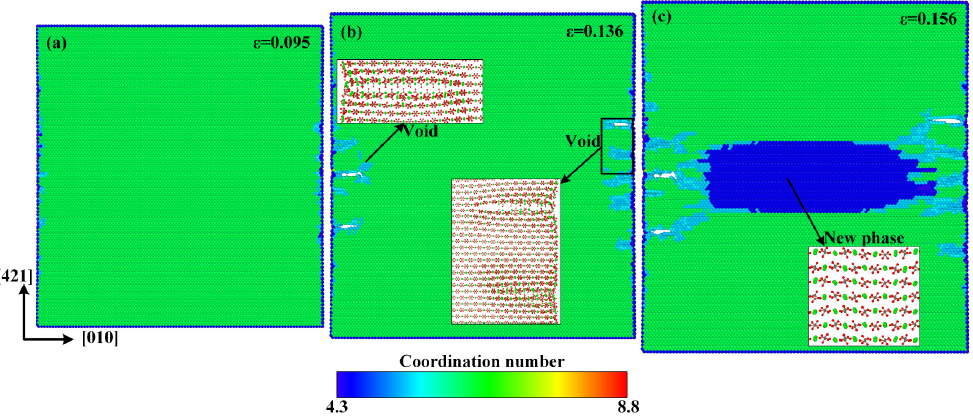
Figure 9. Atomic configurations when the tensile strain along the [421] direction reaches: ( a ) ε = 0.095, ( b ) ε = 0.136, and ( c ) ε = 0.156.